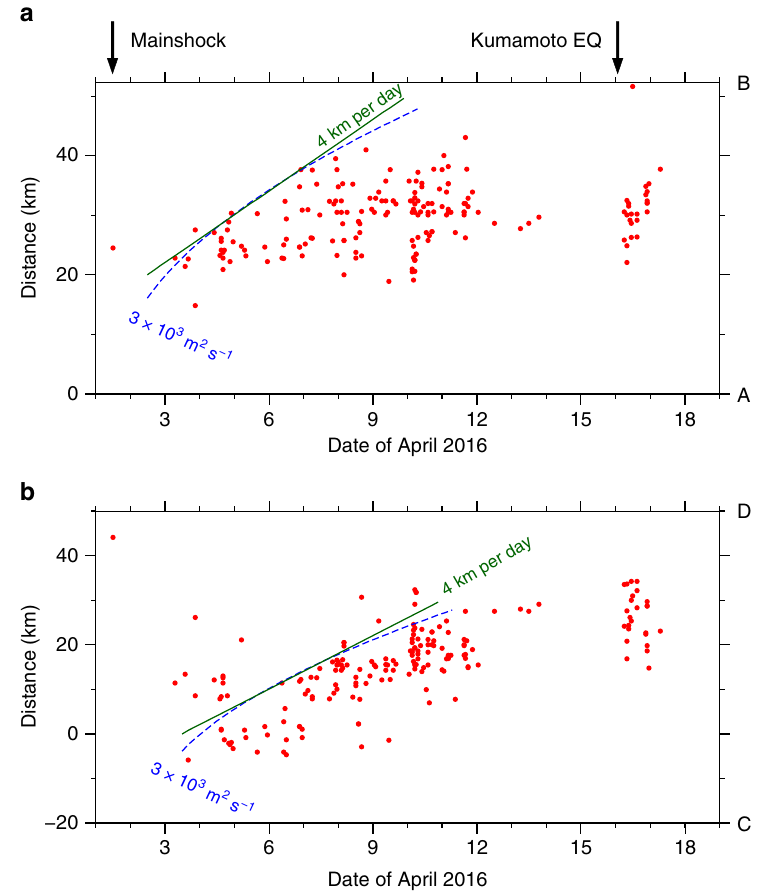
Fig. 5 Migration of sVLFE source location. a sVLFE source locations projected onto line A – B (Fig. 3). Green line indicates migration velocity of 4 km per day; blue curve corresponds to a diffusivity of 3 × 10 3 m 2 s − 1 assuming diffusive migration 44 . b sVLFE source locations projected onto line C –